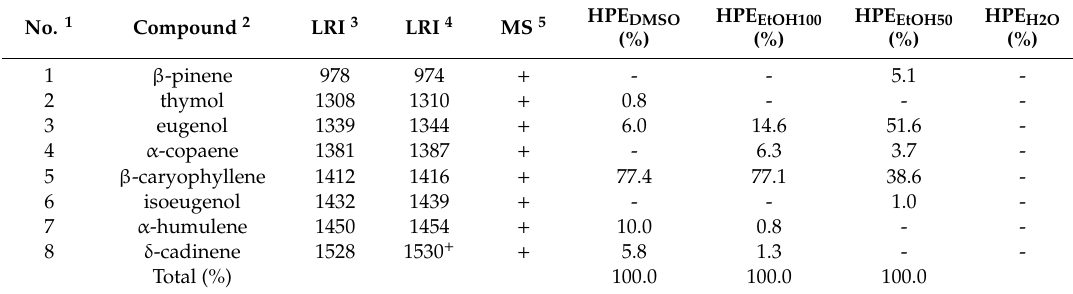
Table 3. Volatile compounds (relative percentage in the volatile fraction) detected in Harpagophytum procumbens root extract (HPE) dissolved in DMSO (HPE DMSO ), 100% v / v EtOH (HPE EtOH100 ), 50% v / v EtOH (HPE EtOH50 ), and deionized water (HPE H2O